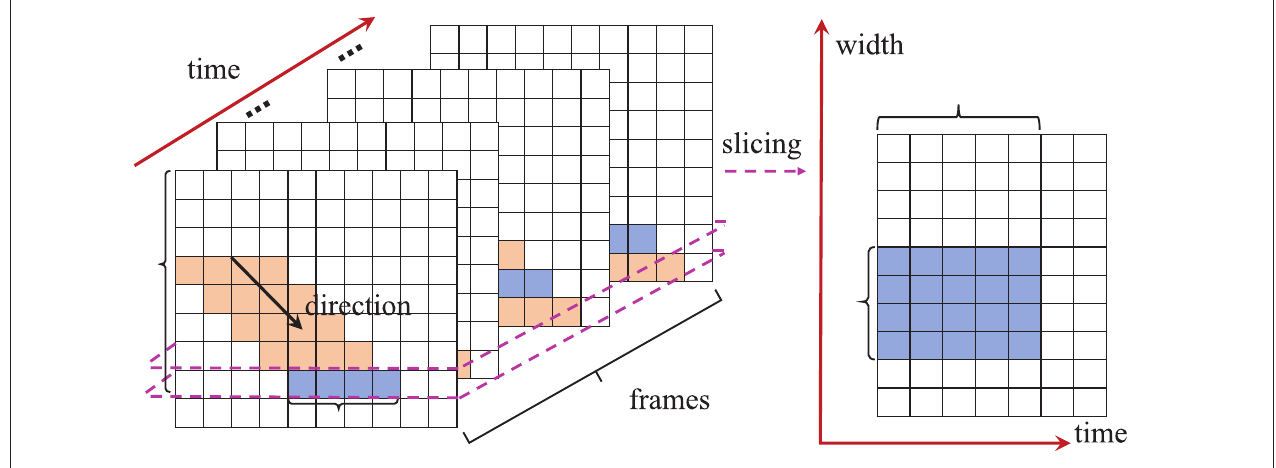
FIGURE 3 | Transformation from normal space to the W-T